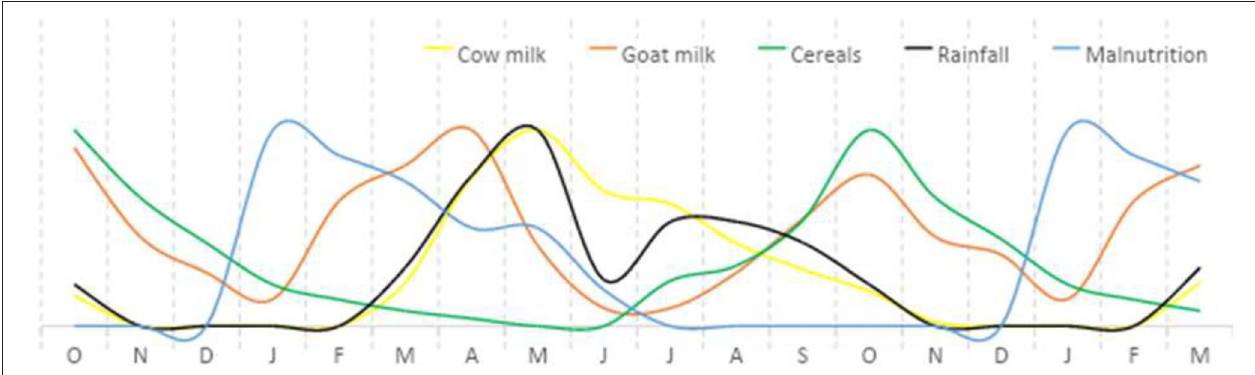
FIGURE 2 | Example of a monthly calendar for a “typical year” for child malnutrition, rainfall, and availability of livestock milk and cereals for human consumption, Karamoja, Uganda, 2018. Monthly calendars with 16 women’s groups; in each group each variable was illustrated by distributing 100 counters across 12 months; summated scores from all 16 groups were used to construct the diagram, and the y-axis scale is arbitrary; the monthly calendar method was based on the Gregorian, solar calendar with 12 months; this example was constructed over an 18-month period to enable comparison of trends over consecutive end of year periods.